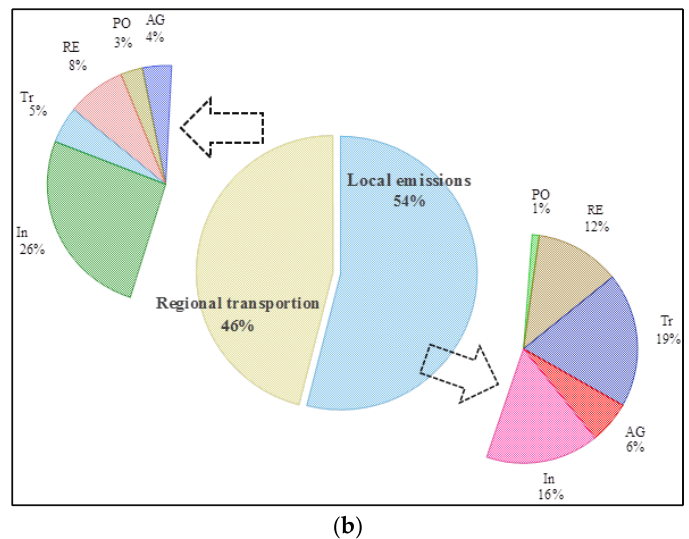
Figure 6. Source apportionment results for PM 2.5. (AG: agriculture, PO: power, RE: residential, and Tr: traffic. In the industry, local: local emissions and Tran: transport from the surrounding region). ( a ) the source apportionment results for PM 2.5 in winter, ( b ) the source apportionment results for PM 2.5 in summer.